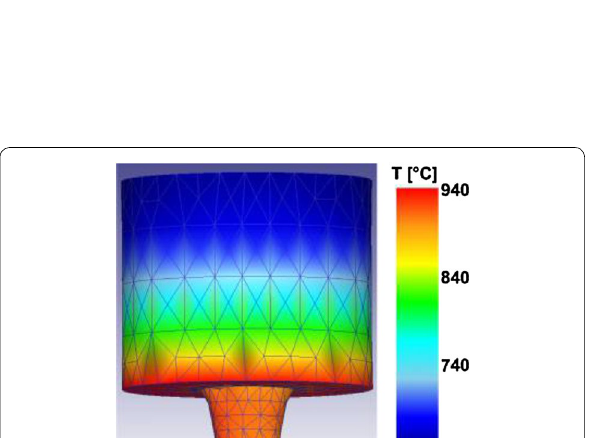
Figure 40 Plot of the temperature at the welding tool [130]